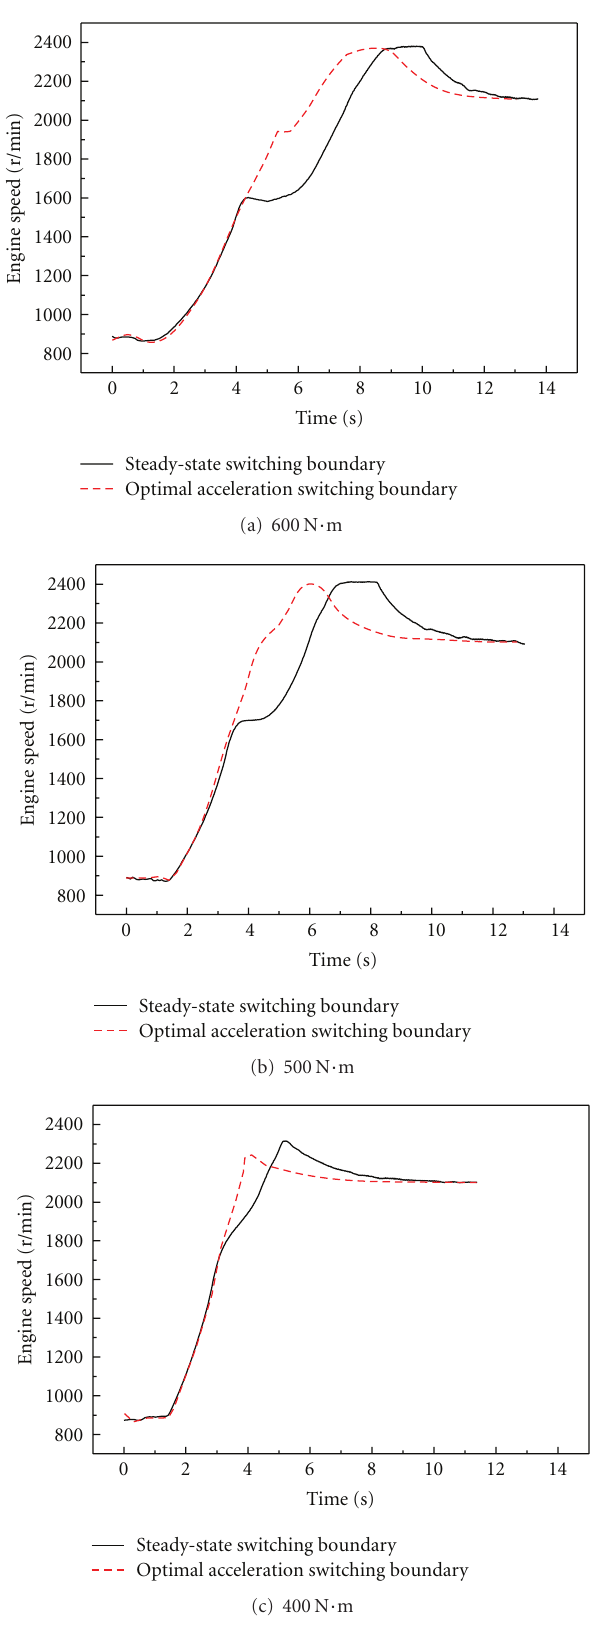
Figure 13: Comparison of the two ST strategies in the engine speed acceleration process from 900 to 2100 r/min at constant torque.